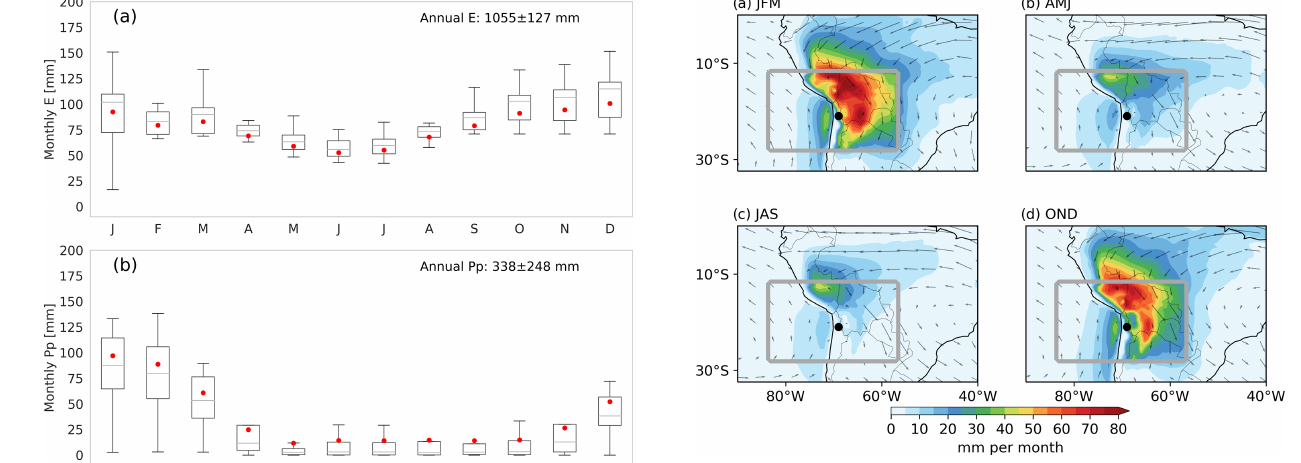
Figure 7. Seasonal variability of moisture sources (shaded) in mm per month and vertical integrated moisture transport (arrows) over the Altiplano region for (a) summer, (b) autumn, (c) winter and (d) spring. The gray squares frame the Altiplano regions and sur- roundings for which the sources are determined. The black dots in- dicate the Salar del Huasco